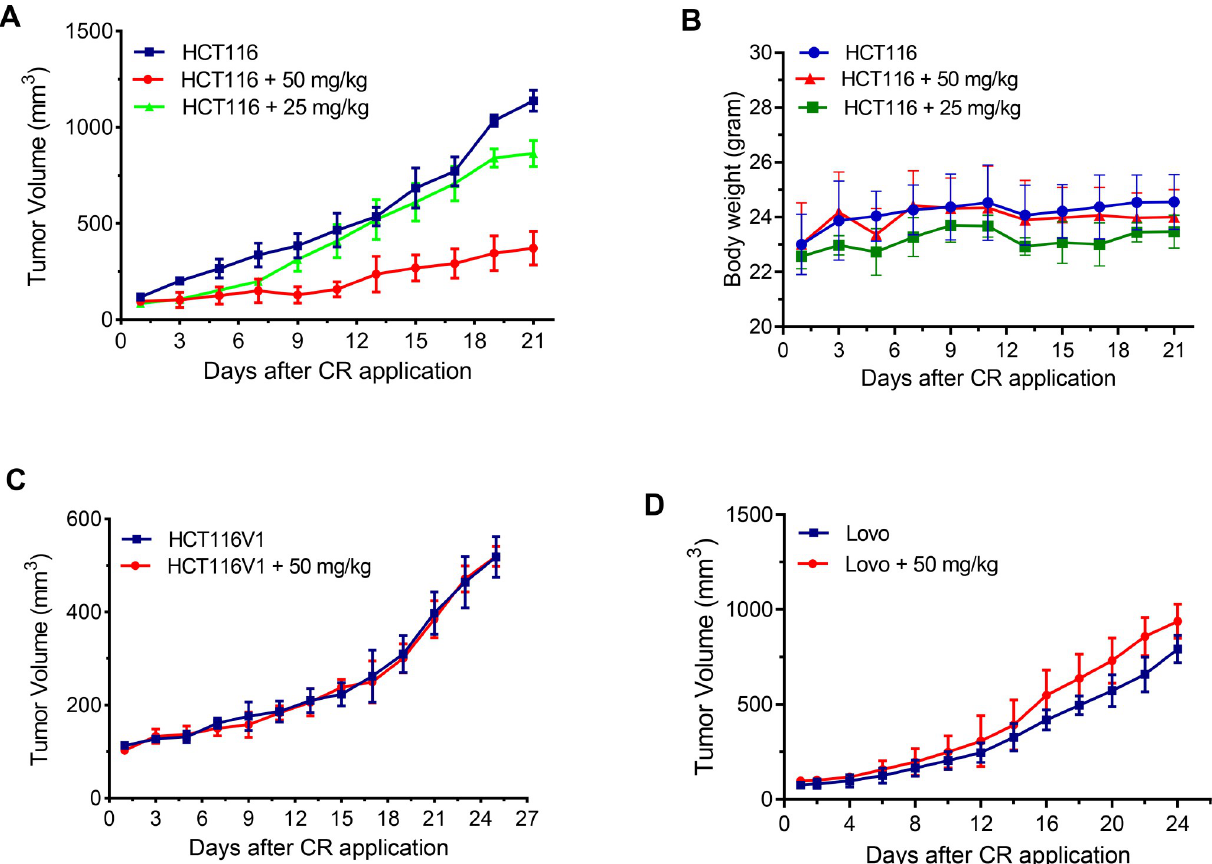
Fig 6. CR suppresses the growth of HCT116 xenograft tumors. (A) Growth curves of HCT116 xenograft tumors (n = 6, tumor volume mm 3 ) treated with CR and 0.02% DMSO (n = 6, control). p < 0.01, 50 mg/kg compared with control group; p>0.05, 25 mg/kg compared with control group. (B) The corresponding body weight changes during the treatment. p>0.05, compared with a control group. (C) Growth curves of HCT116V1 xenograft tumors (n = 3, tumor volume mm 3 ) treated with CR and 0.02% DMSO (n = 3, control). p>0.05, compared with a control group. (D) Growth curves of Lovo xenograft tumors (n = 5, tumor volume mm 3 ) treated with CR and 0.02% DMSO (n = 5, control). p>0.05, compared with a control